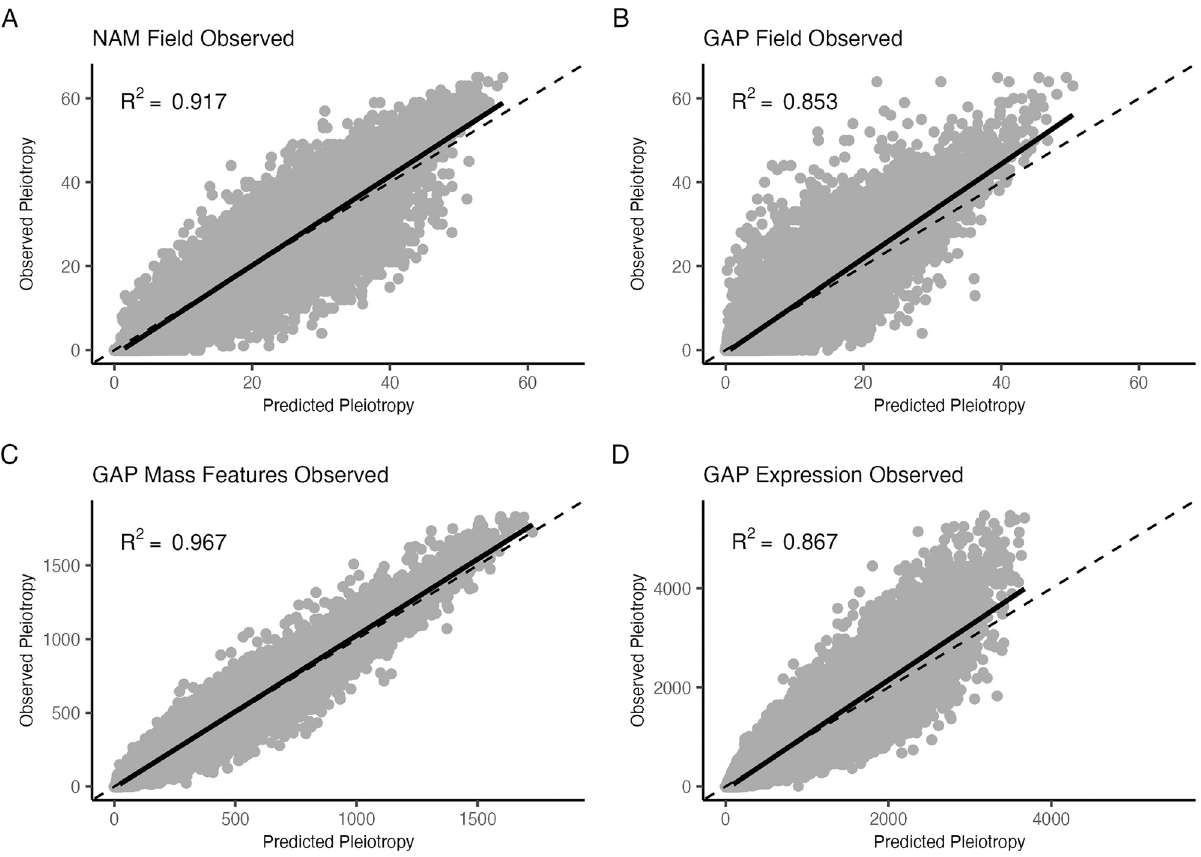
Fig 4. Predicted versus observed pleiotropy values for Model 1 (random forest with only nuisance terms) from four individual random forest models trained on interval-based observed pleiotropy values. The dashed line represents the 1–1 identity line, while the solid line represents fitted values. Panels show the results for the (a) NAM field, (b) GAP field, (c) GAP mass features, and (d) GAP expression data.